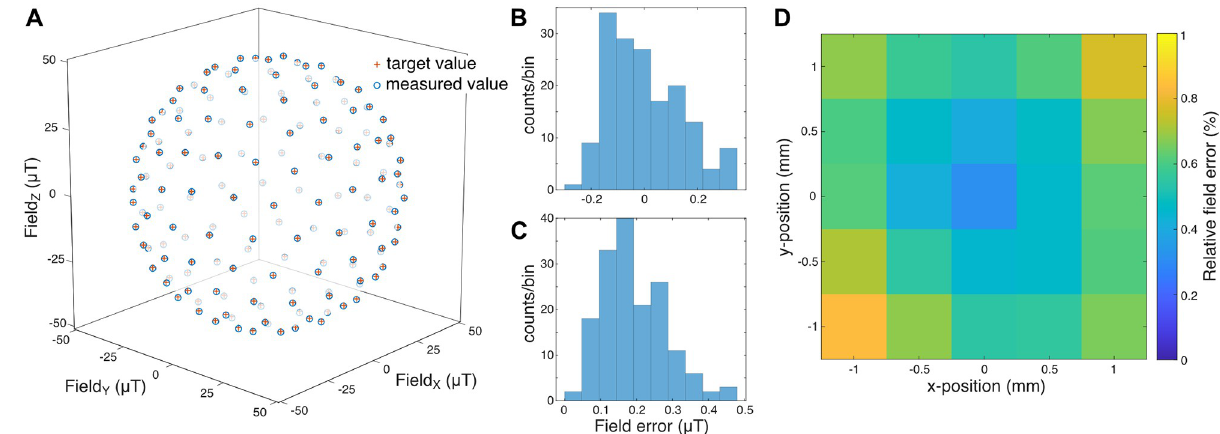
Fig 4. Setup calibration. A: Precision of 162 uniformly distributed field vectors in the calibrated setup. Red crosses: target vector, blue circles: measured field vector B: Magnitude deviations from the target of 50 μ T. C: Euclidean distance between target and measured field vector. D: Field homogeneity in a 2 mm � 2 mm area in the recording chamber. At each location a spherical magnetic field stimulus with 44 vectors was analyzed. For each location, the mean Euclidean error is shown in percent of the target radius.